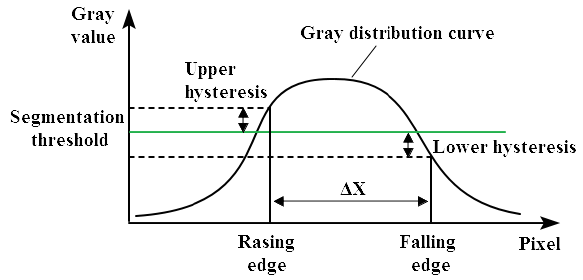
Figure 7. Definition of rising and falling edges. Take the left edge straight line detection process of cross laser-pattern as an example, search each pixel line by line from left to right along horizontal direction, the algorithm is shown in Figure 8. L is 1.2 times the cross-line width in pixel.